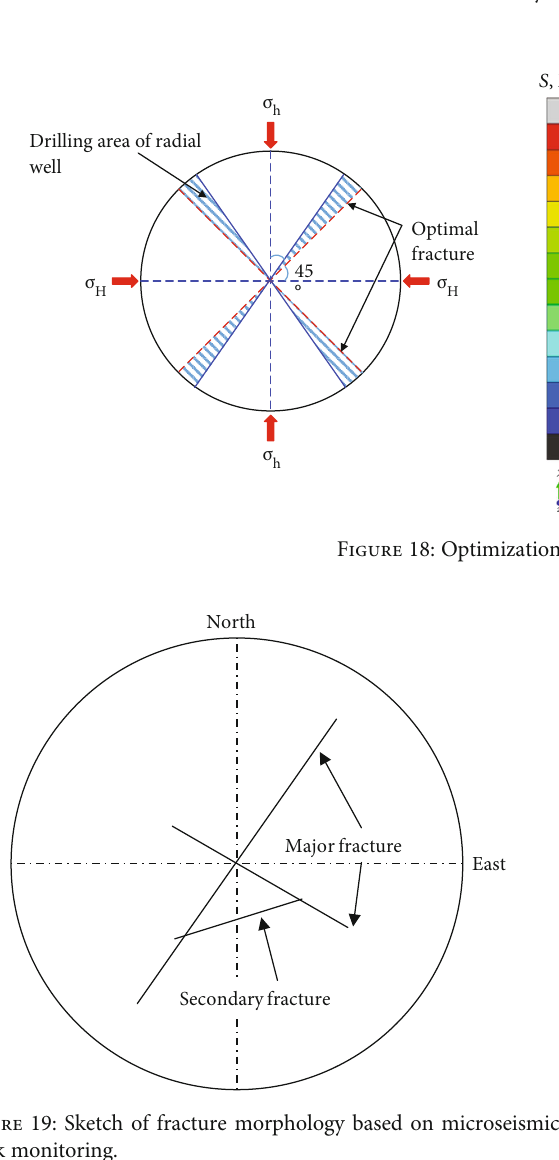
Figure 17: Results and analysis of microseismic crack